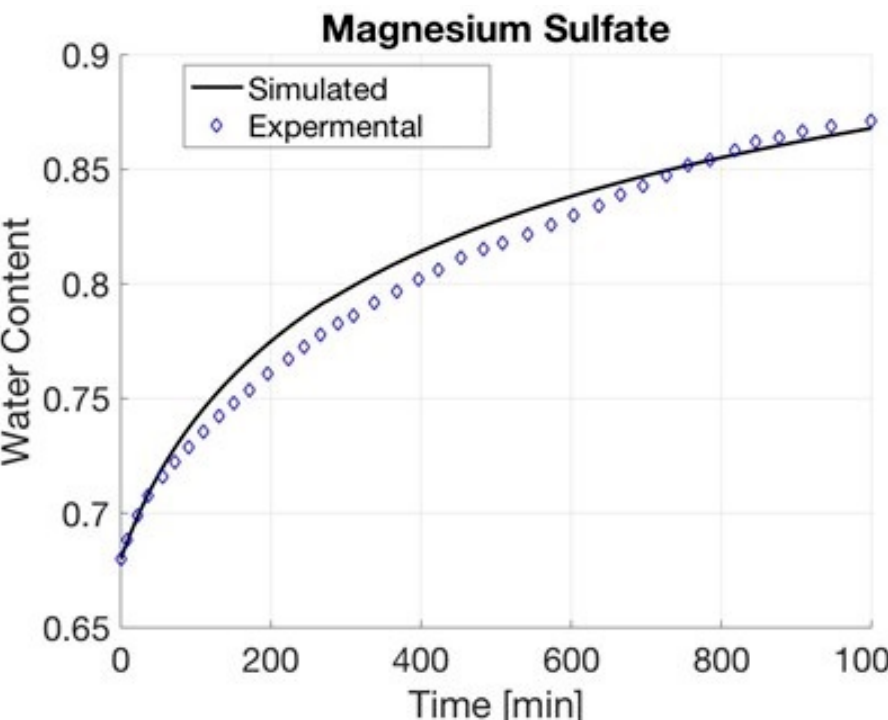
Figure 12. Comparison of HAW model of magnesium sulfate